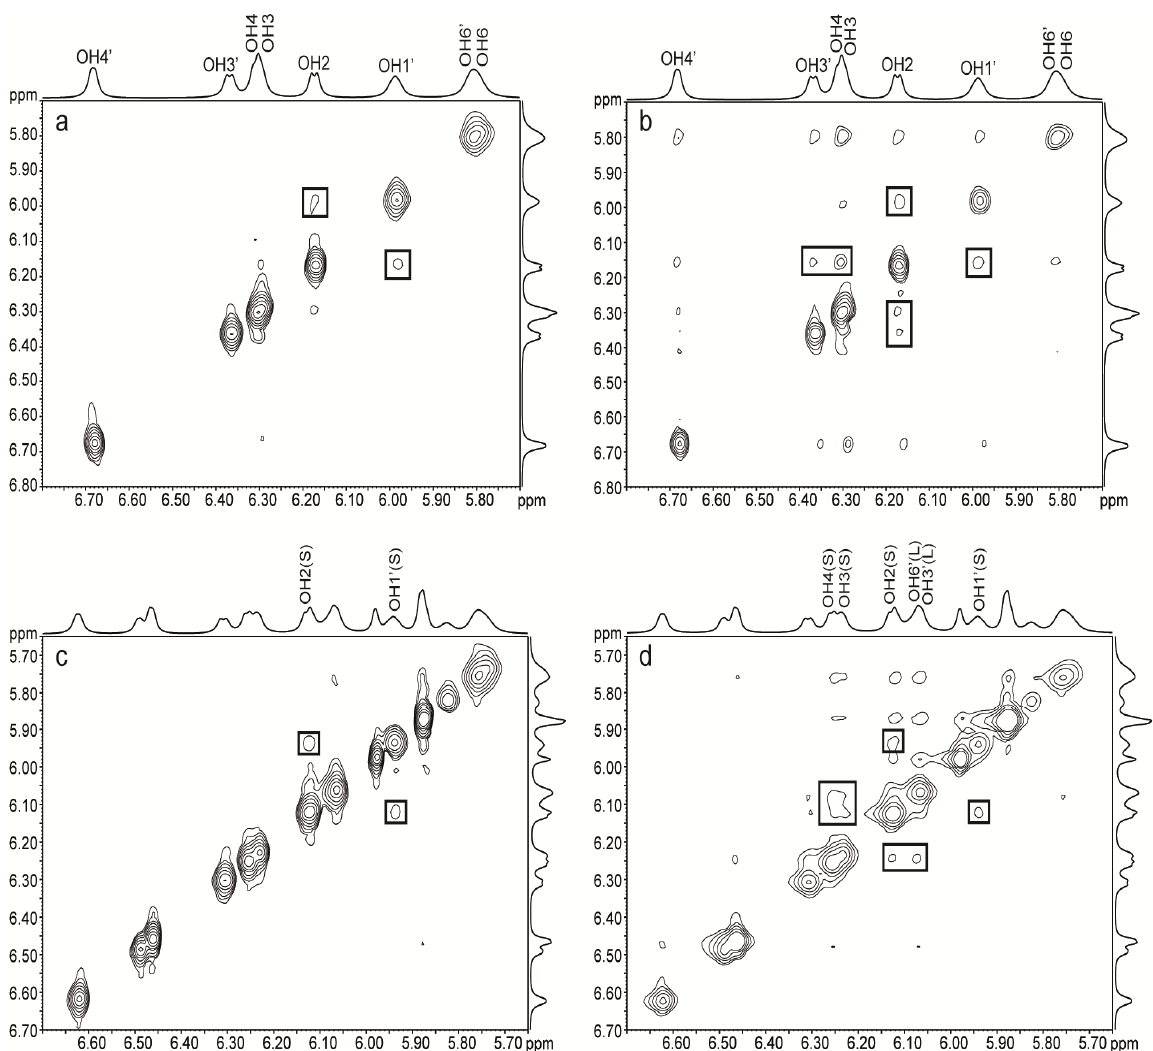
Figure 6. ROESY 1 H-NMR spectra at –5 °C of ( a ) sucrose 202 mg/mL, mixing time 40 ms, ( b ) sucrose 202 mg/mL, mixing time 80 ms, ( c ) sucrose/lactose 178/181 mg/mL mixture, mixing time 40 ms, ( d ) sucrose/lactose mixture 178/181 mg/mL, mixing time 80